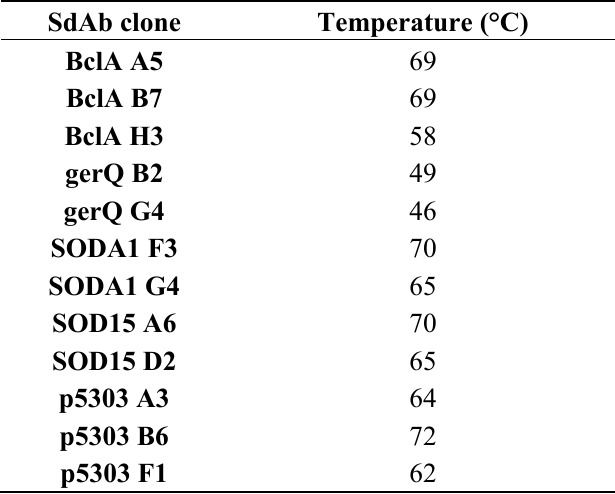
Table 2. SdAb melting temperatures determined using circular dichroism.